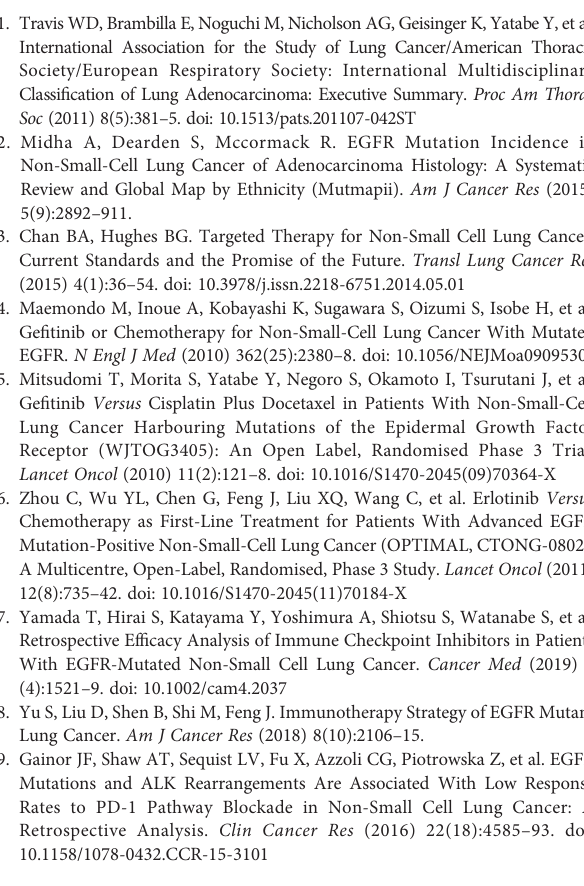
Commons database.